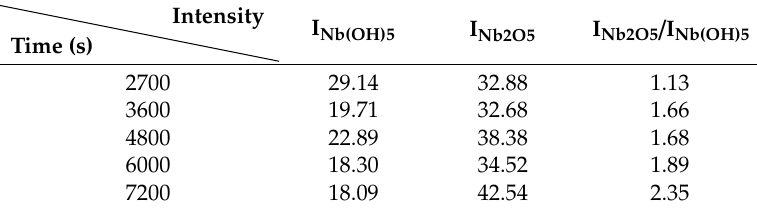
Table 1. Parameters from ATR-IR spectrum at di ff erent